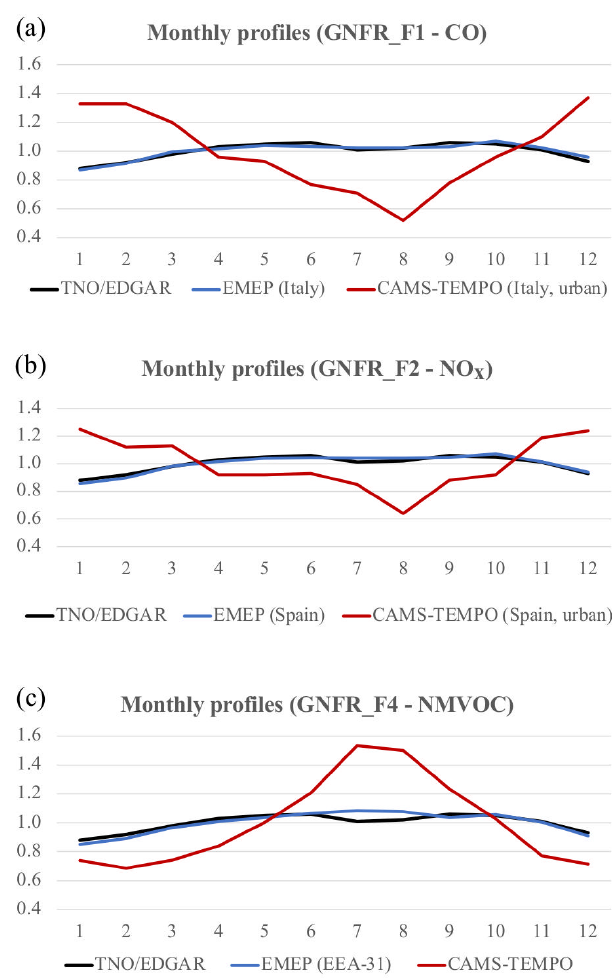
Figure 14. Comparison of monthly profiles for road transport emis- sions developed in the present work (CAMS-TEMPO) with profiles from EDGAR, EMEP and TNO for selected countries and cate- gories: CO gasoline exhaust (GNFR_F1, a ), NO x diesel exhaust (GNFR_F2, b ) and NMVOC non-exhaust (GNFR_F4, c ).